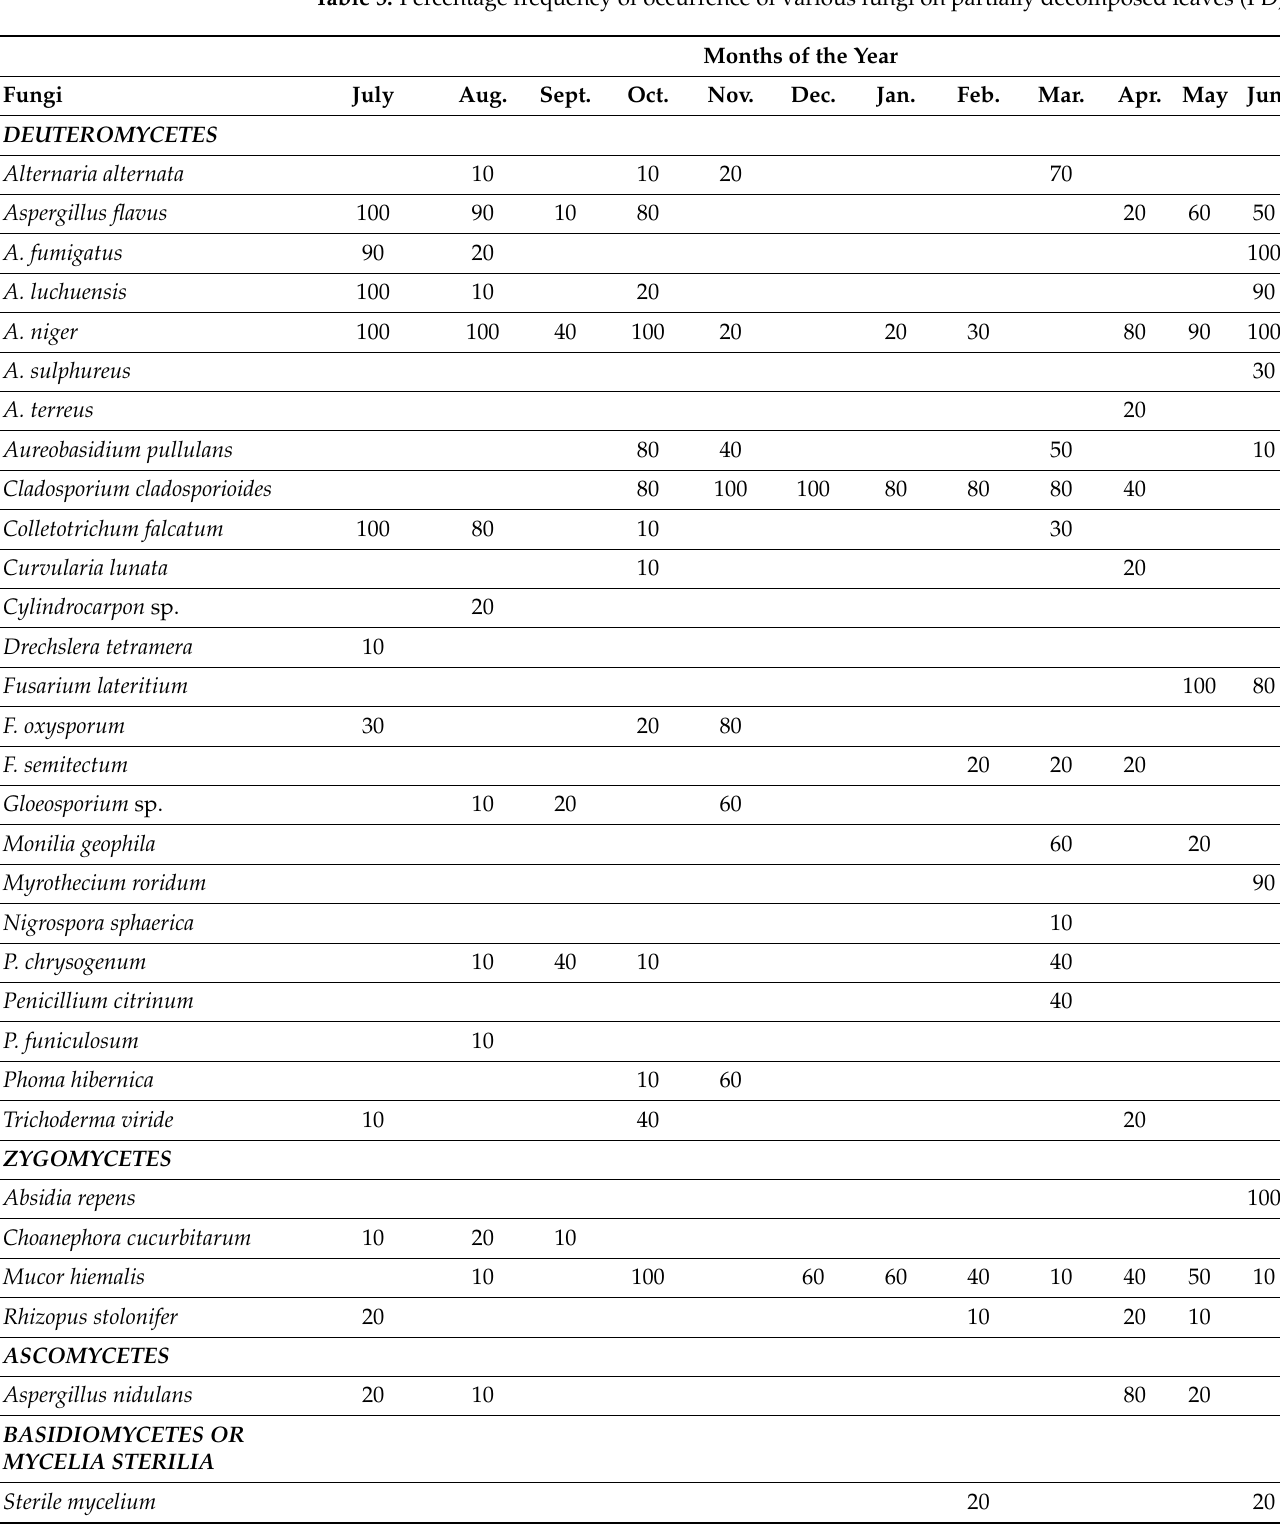
Table 5. Percentage frequency of occurrence of various fungi on partially decomposed leaves